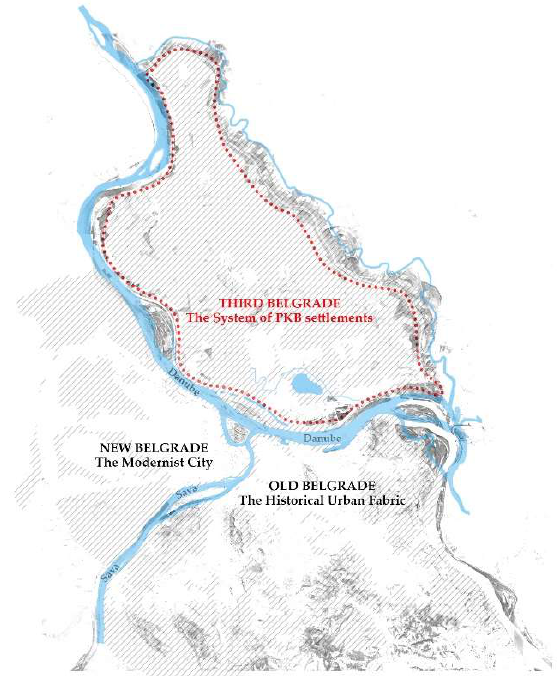
Figure 1. The Case Study spatial framework: Third Belgrade spatial coverage (red lineout). Source: Authors.